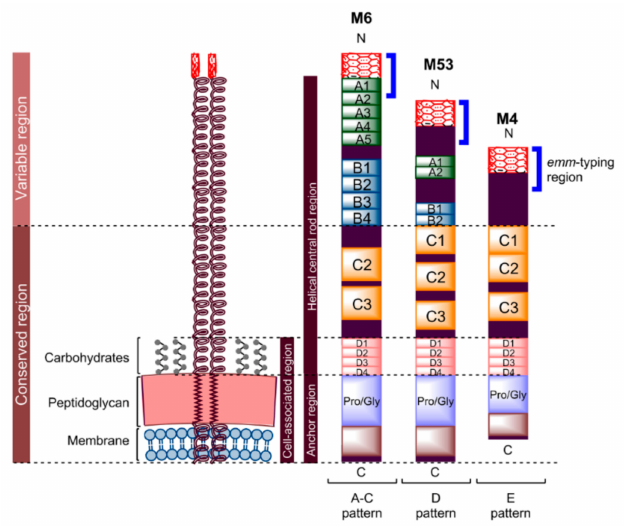
Figure 1. Schematic representation of M protein. All M proteins are similarly organised; they include a hypervariable N-terminus, variable central region, and highly conserved C and D repeats, though M protein varies in length depending on the pattern type [51]. M proteins may have a long A-C pattern (e.g., M6), intermediate D pattern (e.g., M53) or short E pattern (e.g., M4), with an average residue of 444, 355 and 316, respectively. The N-terminus non-helical region of M protein contains a negatively charged amino acid sequence (variable in length) adjoining the A-repeat region [11]. This region enables antibody recognition and electrostatic repulsion with phagocytes. A- and B-repeat regions have di ff erent sizes and numbers of repeat sequences between di ff erent M proteins [10,31,51]. On the other hand, the C-repeat region has a di ff erent number of repeat sequences, but with similar sequence identity. This conservation in sequence increases with the D-repeat region. These four regions form a helical central rod for M protein. The non-repeating block containing an excess of proline and glycine amino acids adjacent to the D-repeat region enables the M protein to traverse the cell wall. Whereas, 20 hydrophobic and six charged amino acids at the end of the C-terminus help the protein to extend along and anchor to the bacterial cytoplasmic membrane [61]. This cell-associated region is shorter in the E pattern of M protein compared to the other types, with 29 residues instead of 48